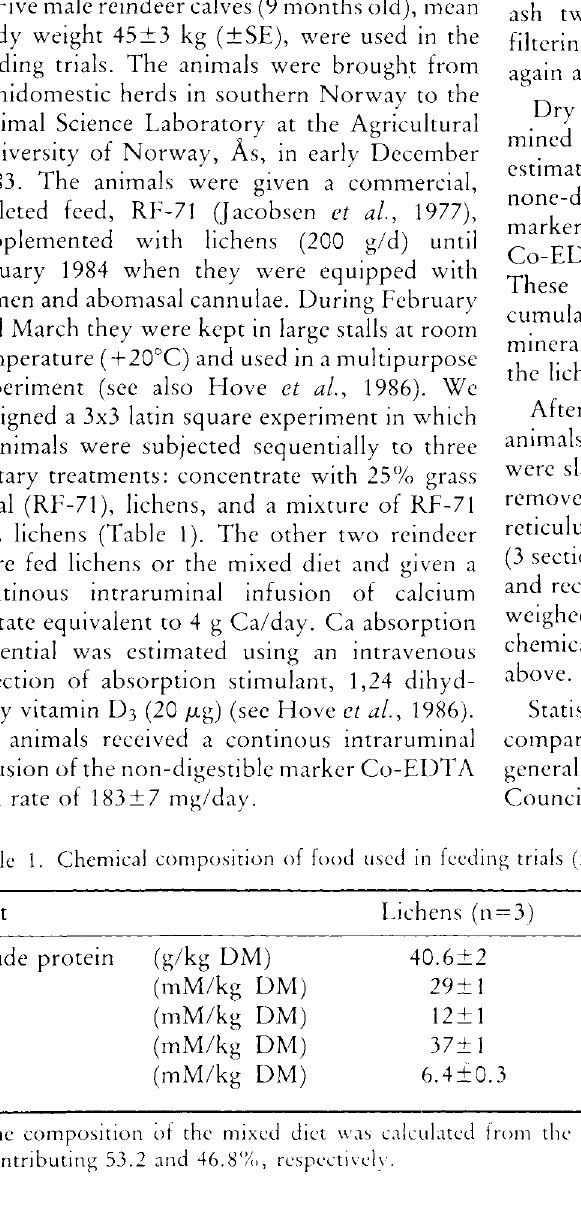
Table 1. Chemical composition of food used in feeding trials